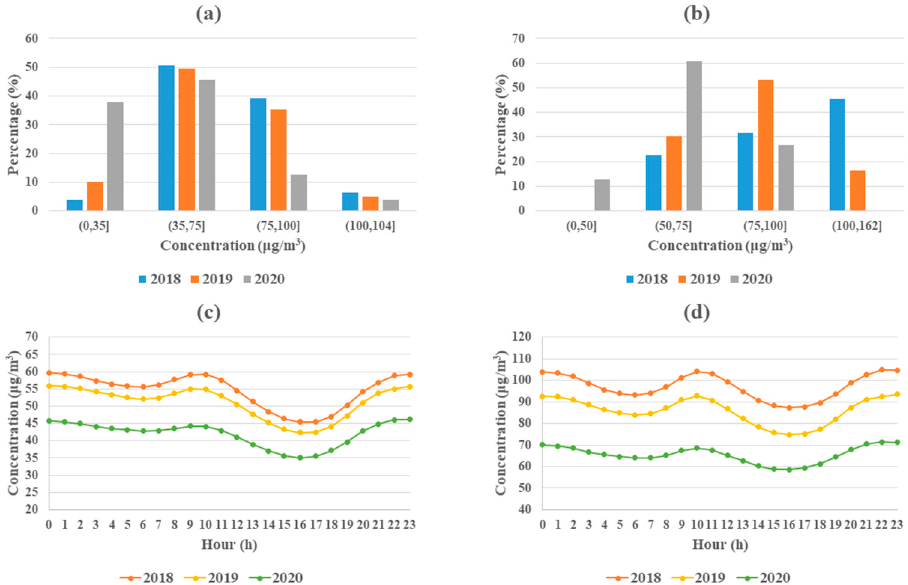
Figure 3. Temporal statistics. ( a , b ) The days proportion distribution of daily average PM 2.5 and PM 10 concentrations, respectively; ( c , d ) The hourly PM 2.5 and PM 10 concentrations change, respectively.